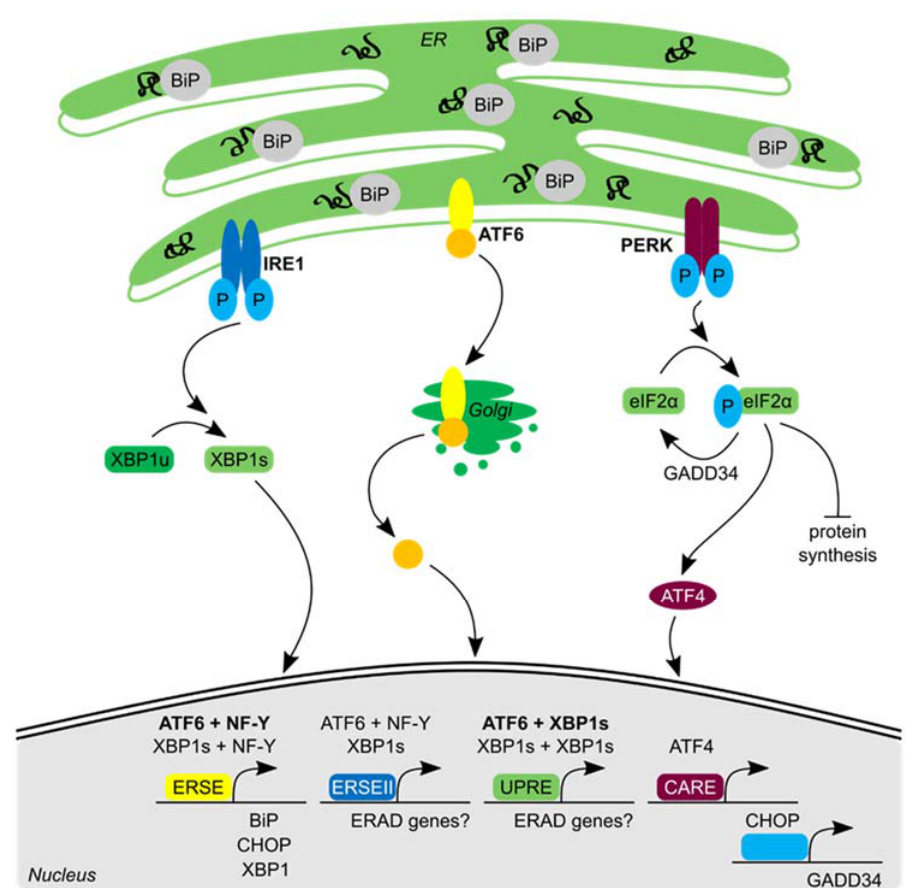
Figure 1. Signaling and gene regulation of the canonical cell autonomous unfolded protein response (UPR). The accumulation of unfolded proteins in the endoplasmic reticulum (ER) induces the three signaling cascades initiated by the transmembrane proteins: IRE1, ATF6 and PERK. This results in the inhibition of protein translation through PERK and the production of active transcription factors: XBP1s, ATF6 and ATF4 via IRE1, ATF6 and PERK, respectively. Upon translocation to the nucleus, XBP1s and ATF6 bind in different compositions to specific promoter sequences, including ERSE, ERSE-II and UPRE, and initiate transcription of multiple UPR genes, including ER chaperones and ERAD genes. Nuclear ATF4 binds the CARE promoter motif and induces CHOP transcription, which in turn increases GADD34 levels, thereby providing negative feedback in the PERK pathway. For details see main text.